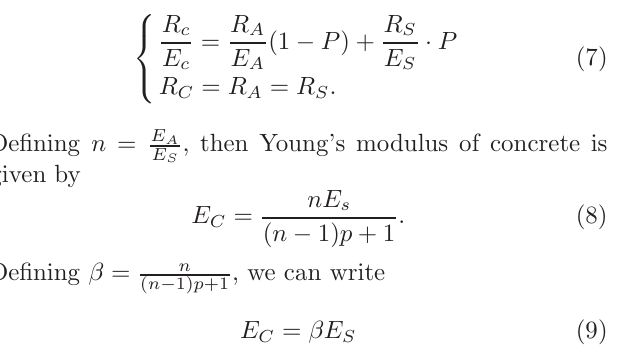
Fig. 2. Young’s modulus ratio of concrete, aggregate and